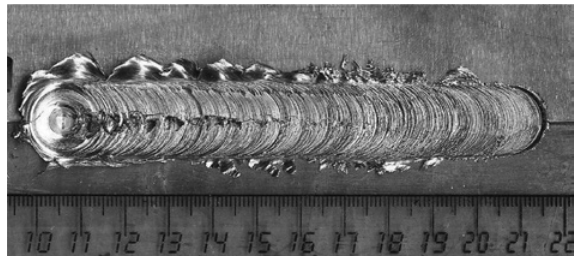
Figure 2: Weld coupon obtained at parameters, 300–1000 rpm, 50 mm/min welding speed, zero IO, from FSW between 2024-T3 Al alloy and AZ31B-O Mg alloy plates; tool withdrawn at about 700